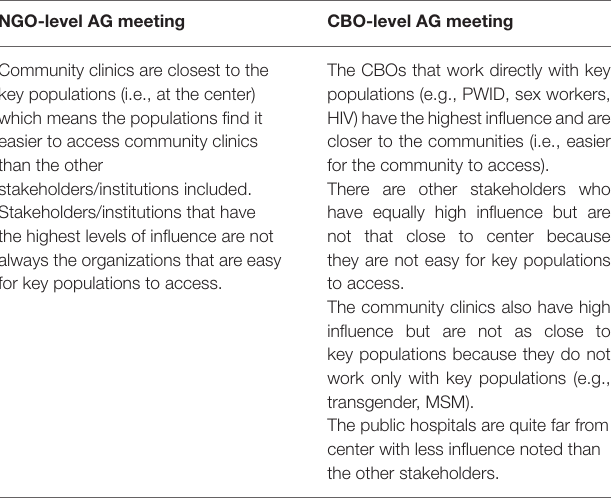
TABLE 2 | Key differences between the NGO-level and CBO-level regarding key stakeholders in community, based on Venn diagram. NGO-level AG meeting